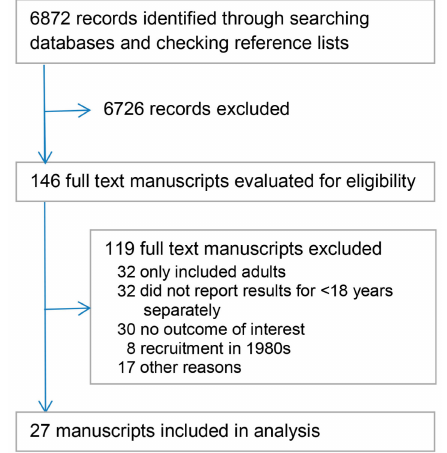
Figure 1. Summary of study search and selection. Table 1. Summary of characteristics of included